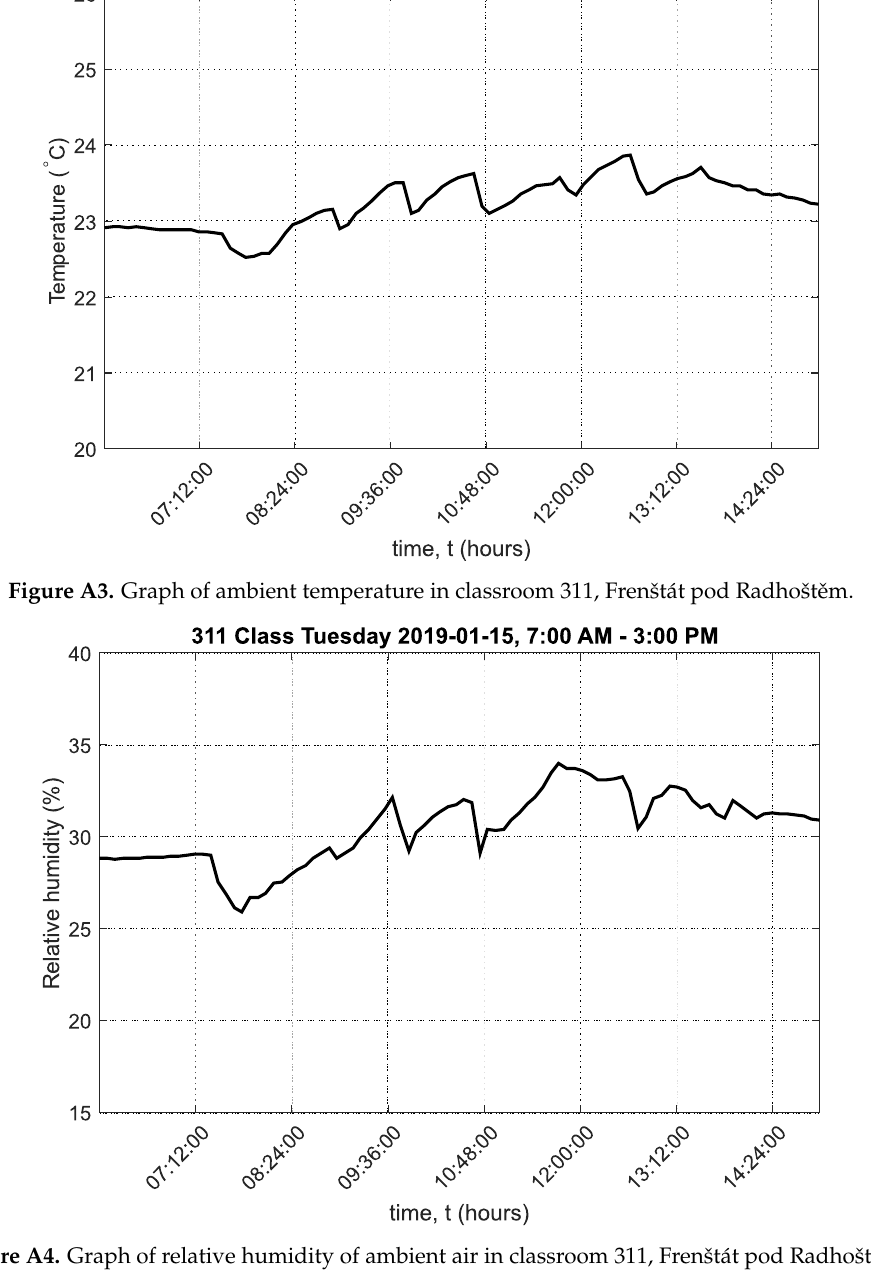
Figure A4. Graph of relative humidity of ambient air in classroom 311, Frenštát pod